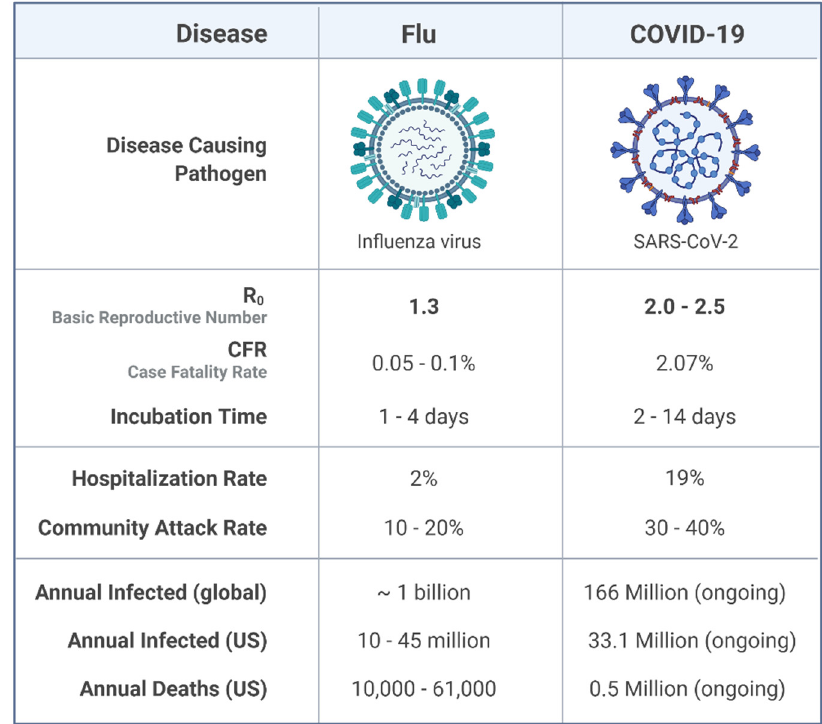
Figure 3. Epidemiological comparison of Influenza A and COVID-19.